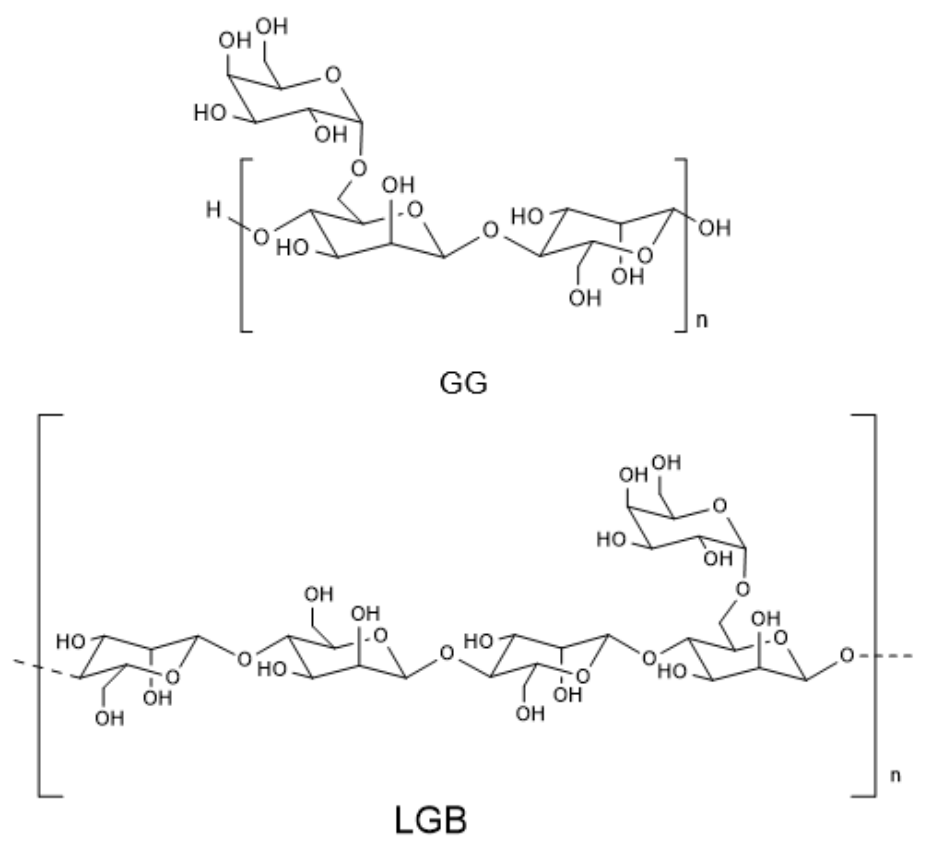
Figure 4. Chemical structure of guar gum (GG) and locust bean gum (LGB).